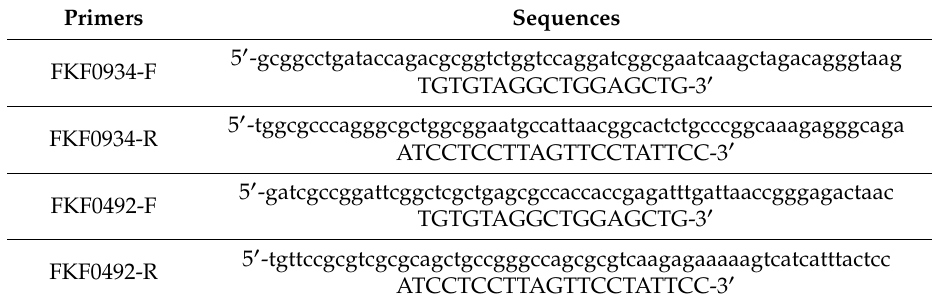
Table 2. Primers and sequences used in the construction of the kanamycin resistance gene cassettes. Sequences in lower cases are 60 bp homologous to the portions of the 5 ′ and 3 ′ ends of the target genes.